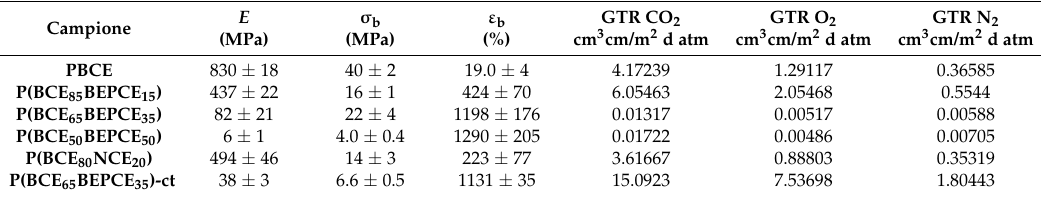
Table 4. Mechanical characterization and gas transmission rate (GTR) data for PBCE, P(BCE m BEPCE n ), and P(BCE 80 NCE 20 ) random copolymers. GTR data are normalized for the thickness of the film sample and are measured at 23 ◦ C, with N 2 , O 2 , and CO 2 dry gas